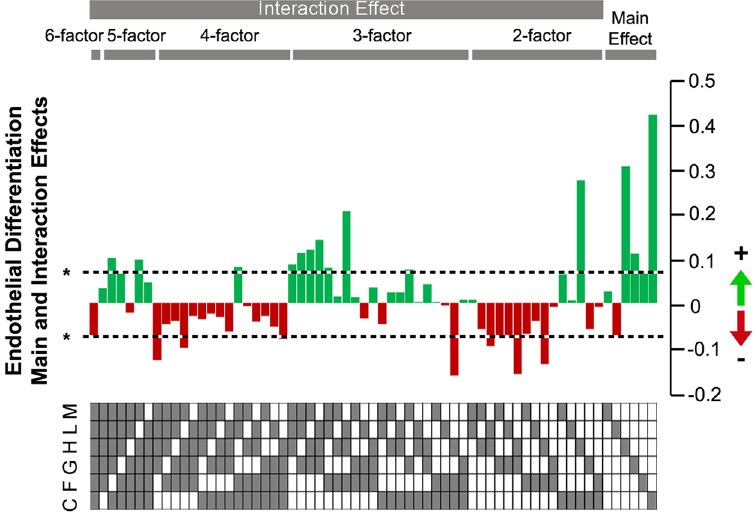
Figure 3. Main and multi-factorial ECM interactions based on CD31 expression. Based on the CD31 expression data generated from iPSCs (HUF5, n = 5), iPSCs (DOX1, n = 3) and ESCs (H1, n = 5), the ECM combinations were grouped and ranked by 1-factor, 2-factor, 3-, 4-, 5- and 6-factor combinations. Main and multi-factorial ECM effects were analyzed and compared as coefficients in a multi-way ANOVA model. The graph depicts the main effects measured by the change in CD31 expression when the listed ECM component is present vs. absent. A positive effect is indicated by green bars, whereas red bars denote negative effects. 0 represents neither positive nor negative effect. The dotted line indicates * P < 0.05.